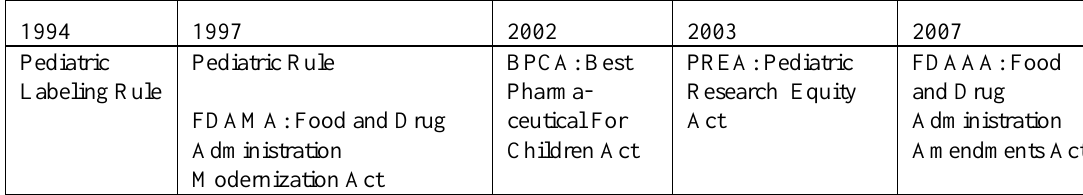
Table 1. Major milestones of pediatric legislation in the